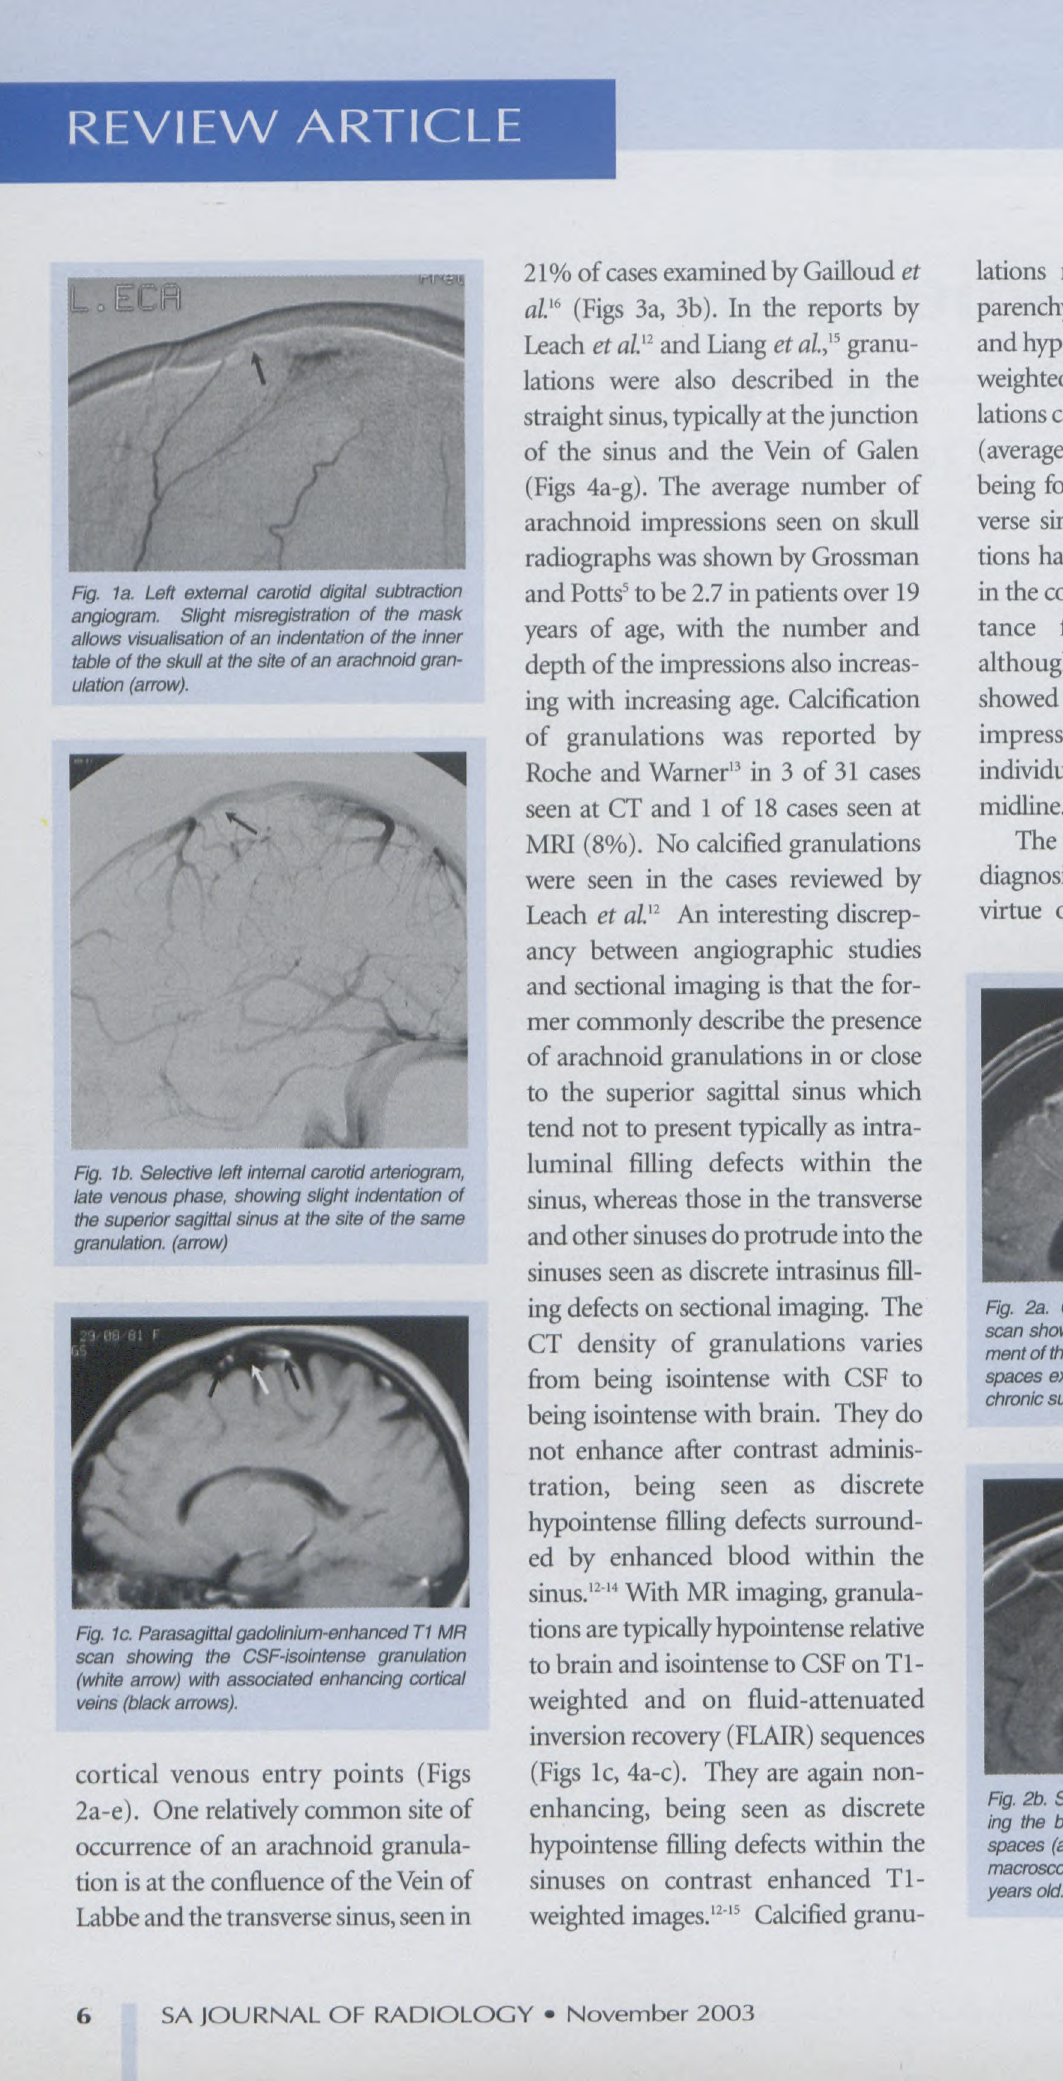
Fig. 2b. Sagittal image, same case, again show- ing the bridging veins traversing the arachnoid spaces (arrows). No arachnoid granulations are macroscopically evident in this patient who is 2 years